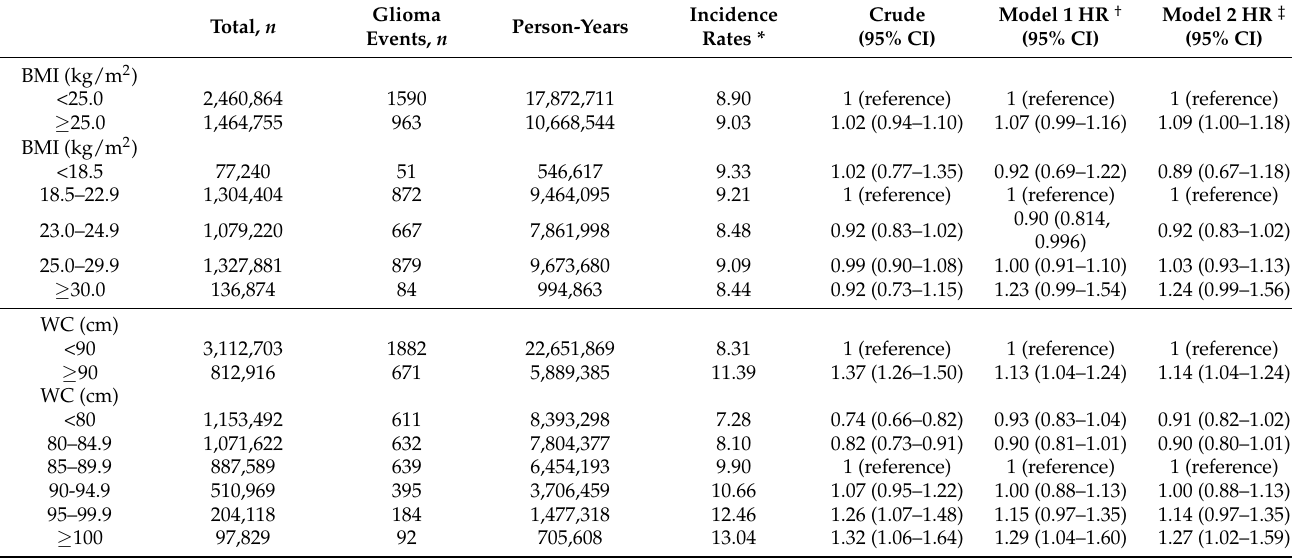
Table 4. Incidence rates and risks of glioma development according to BMI and WC in males. Glioma Total, n Person-Years Events, n